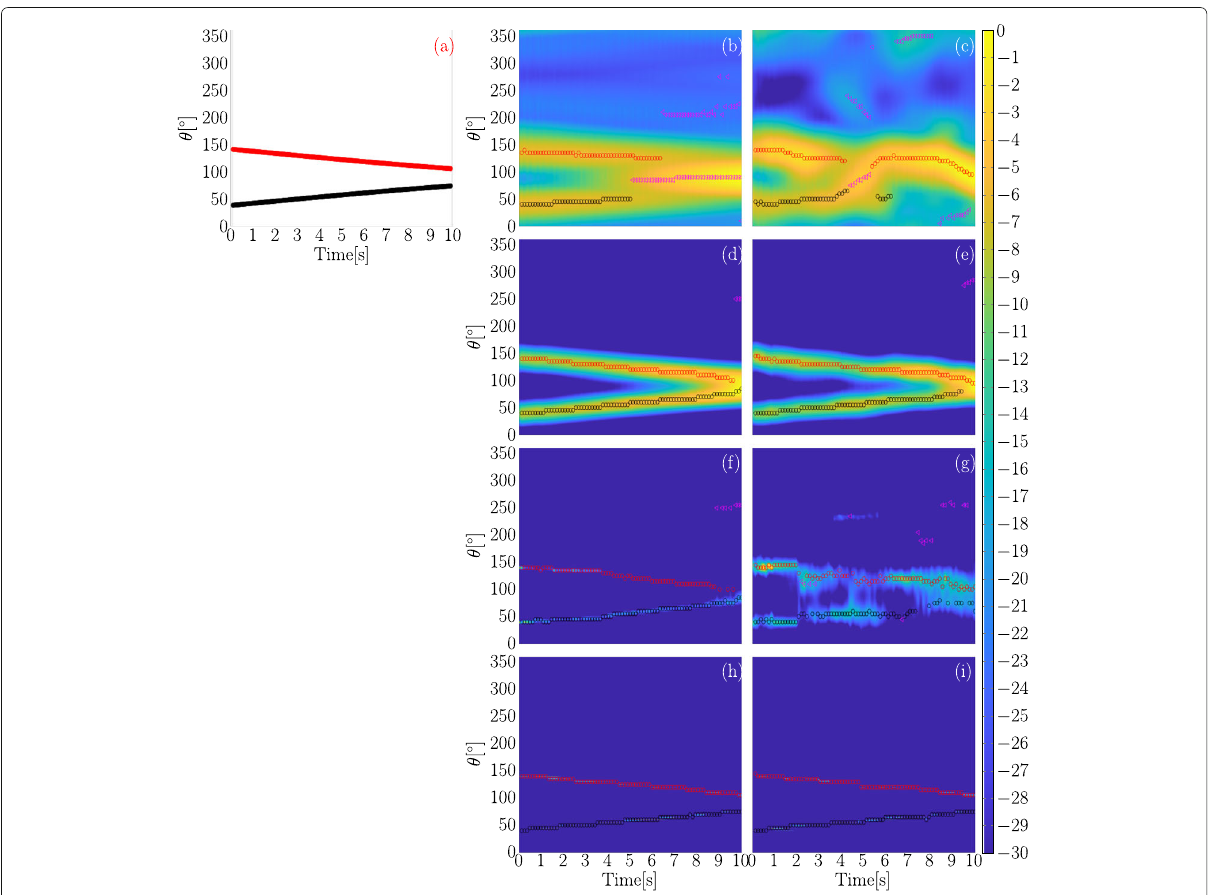
Fig. 9 Estimation results for the second virtual room setup. For the CBF, MVDR and SRP-PHAT methods, the estimation results are shown using the spatial spectrum of all frames. For the proposed SAVE-MSBL-EM method, the estimation results are shown using the weights w of all frames. a The trajectories of two source. b Estimation result of CBF method in free field. c Estimation result of CBF method in low reverberation. d Estimation result of SRP-PHAT method in free field. e Estimation result of SRP-PHAT method in low reverberation. f Estimation result of MVDR method in free field. g Estimation result of MVDR method in low reverberation. h Estimation result of the proposed method in free field. i Estimation result of the